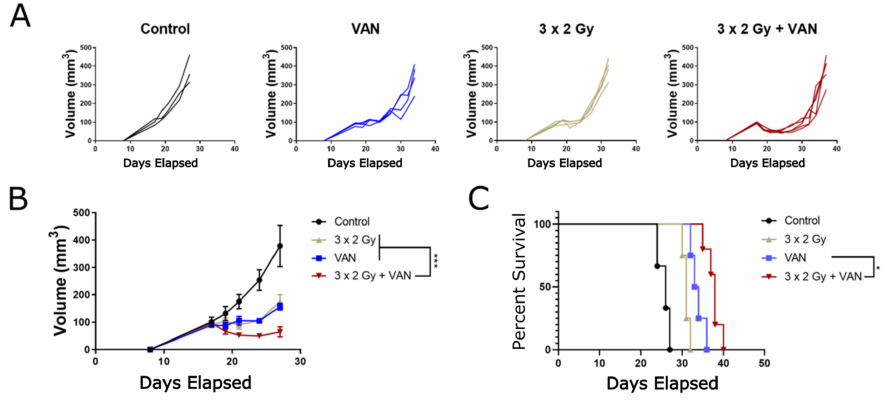
Figure 6. Immunocompetent mouse model of HCC shows significant anti-tumour effect of vandetanib-radiation treatment over single therapy. Immunocompetent BALB/C mice were engrafted with BNL.1ME tumours and administered fractionated radiotherapy on days 17, 18, and 19 and/or vandetanib treatment on days 17–24. Tumour growth was measured in three dimensions until culling. ( A ) Tumour volume for all mice by treatment cohort. ( B ) Mean tumour volume. ( C ) Survival curve. Combined treatment was significant ( p ≤ 0.001) with respect to tumour volume and significant ( p ≤ 0.05) with respect to overall survival against both regimes and control. Volume growth curves are expressed as mean ± SEM and analyzed by extra sum-of-squares F test. Survival is represented by a Kaplan–Meier plot. Log-rank test. * p ≤ 0.05, *** p ≤